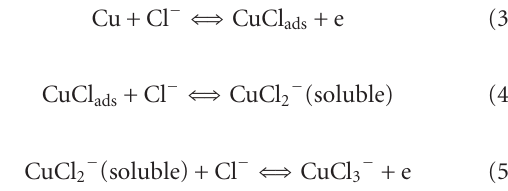
Figure 2: Nyquist plots of copper in 0.5-MHCl, (A) without ATA, (B) with 10 mM of ATA. Inset: the proposed equivalent circuit of the impedance